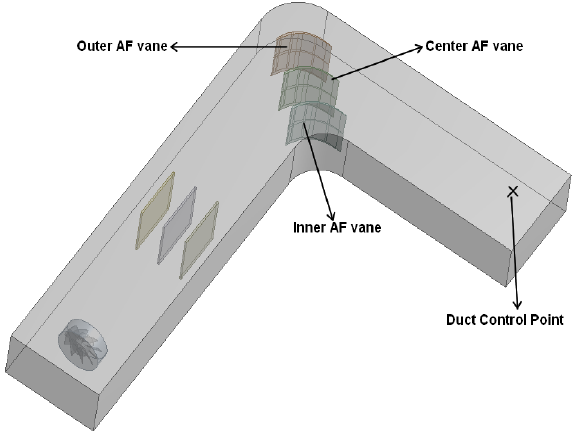
Figure 5. Computational domain (cross-section) of the air duct with the vanes in the shape of thin